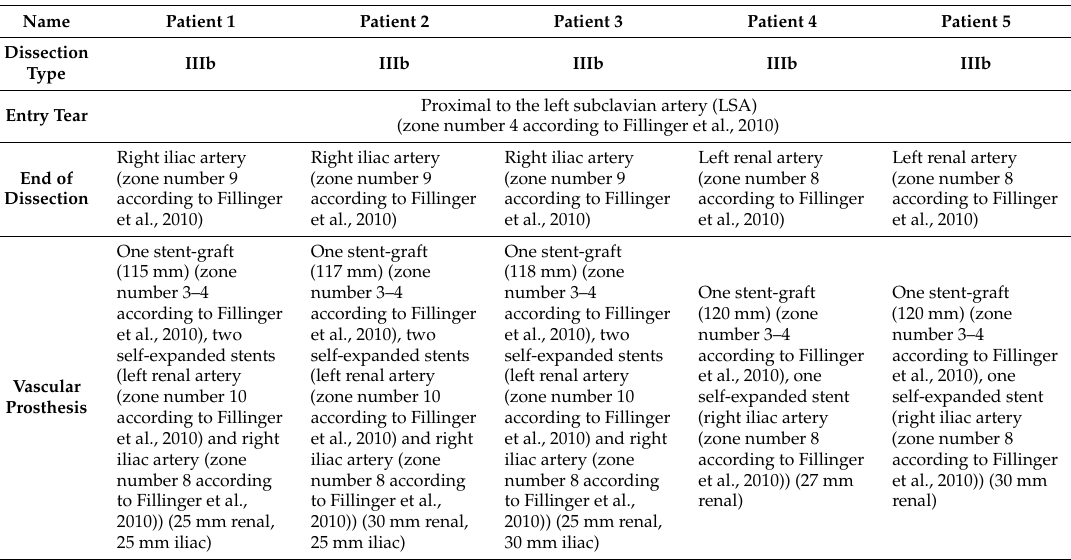
Table 1. Spatial characterisation of analysed patients. Dissection and prosthesis placement according to Fillinger et al., 2010